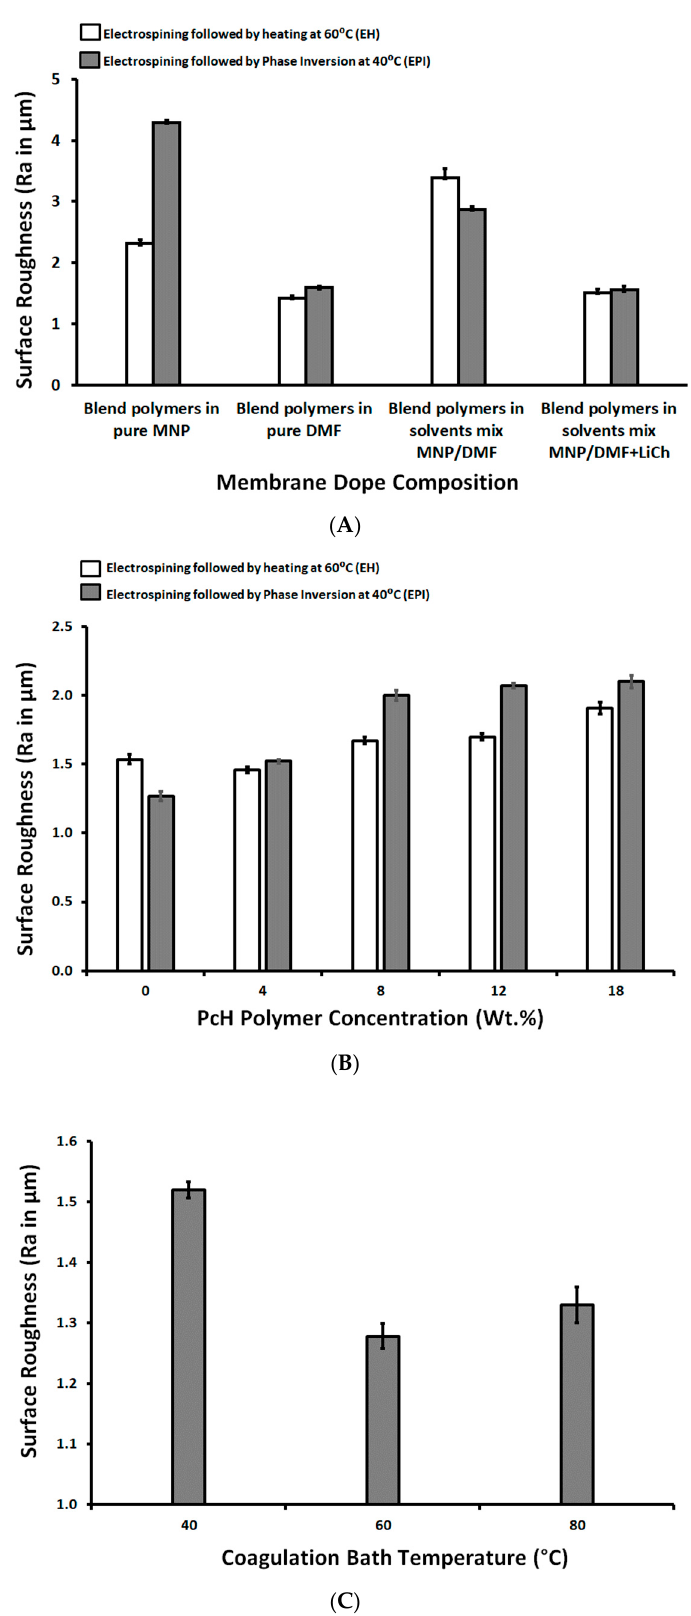
Figure 5. Surface roughness as a function of membrane dope composition (wt.%; A ), as a function of PcH polymer concentration in the membrane dope (wt.%; B ), and as a function of coagulation bath temperature (°C; C ).